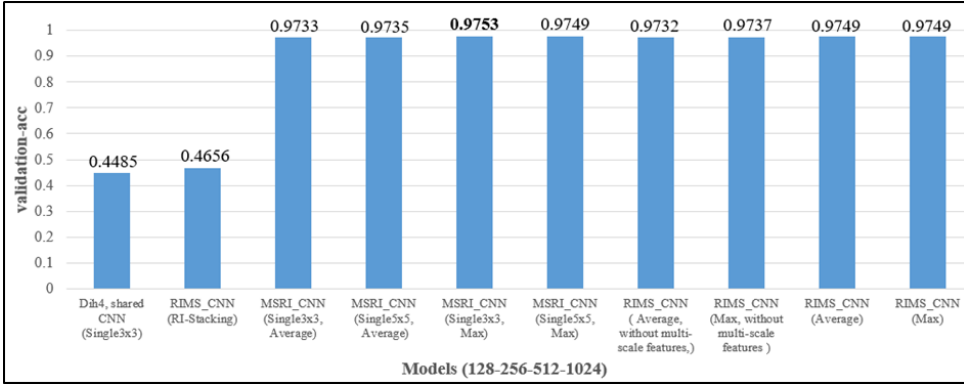
Figure 24. Evaluating different feature-extracting structures on the fixed-angle rotated MNIST.